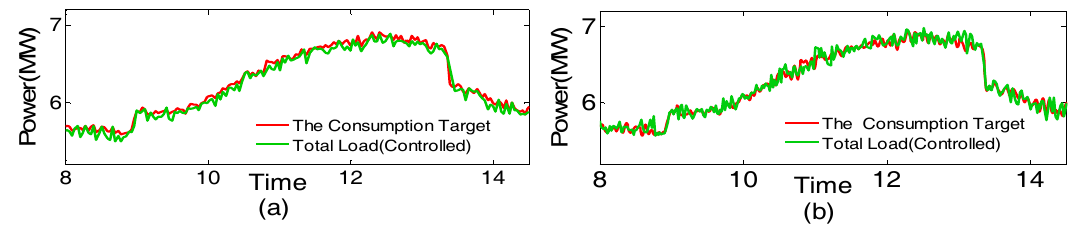
Figure 10. Consumption results ( a ) of 70 s control cycle and ( b ) of 50 s control cycle.